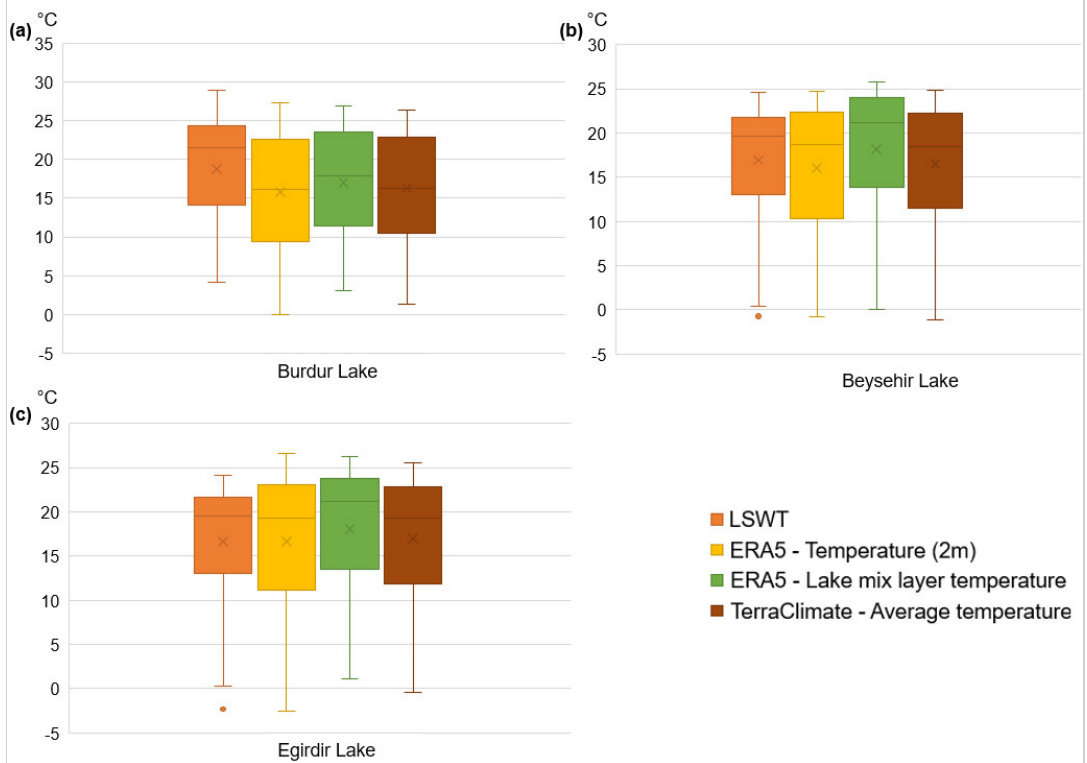
Figure 16. Long-term time series statistics of produced LSWT and temperature dataset of ERA5 and TerraClimate ( a ) Burdur Lake; ( b ) Beysehir Lake and ( c ) Egirdir